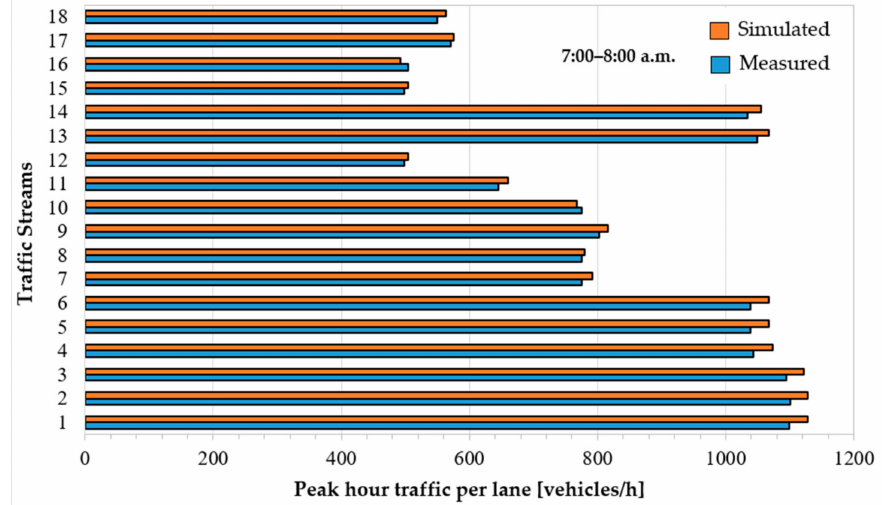
Figure 6. Comparison of simulated and measured peak hour traffic per